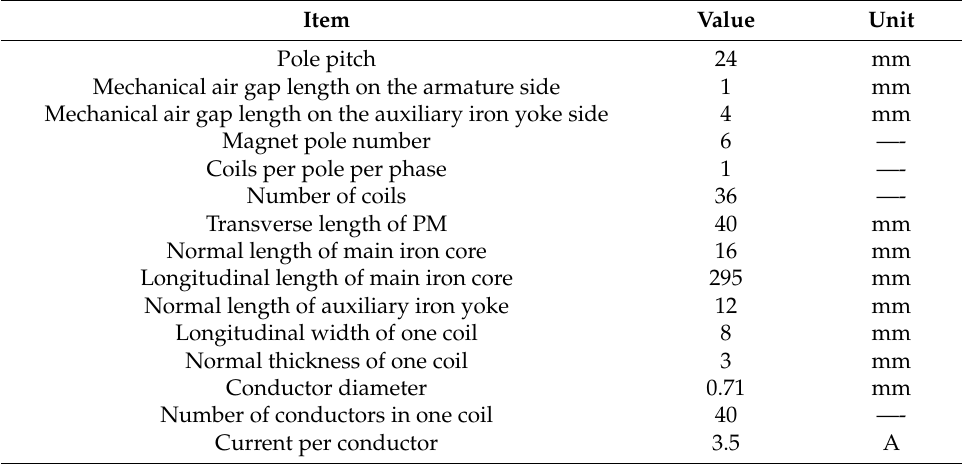
Table 7. Main parameters of the prototype.